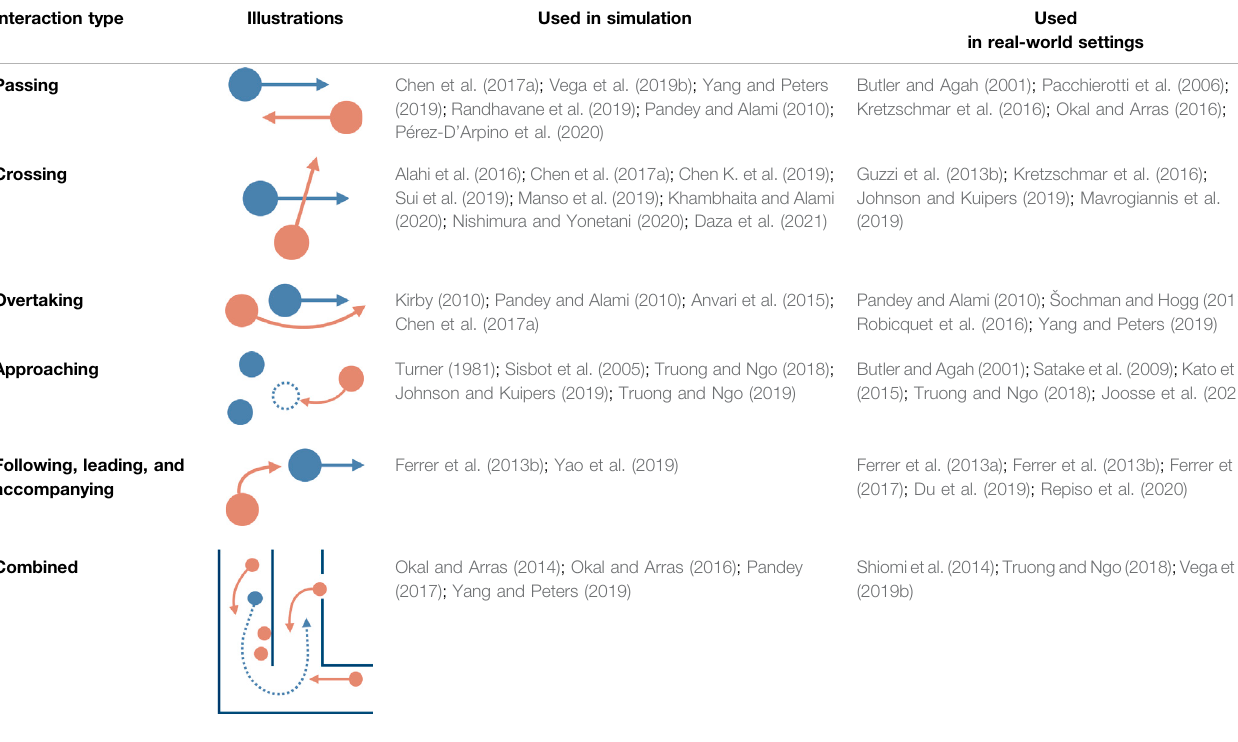
TABLE 2 | Scenarios commonly used in evaluating socially-aware navigation. The publications that employ each scenario in simulation or real-world settings are listed respectively. Interaction type